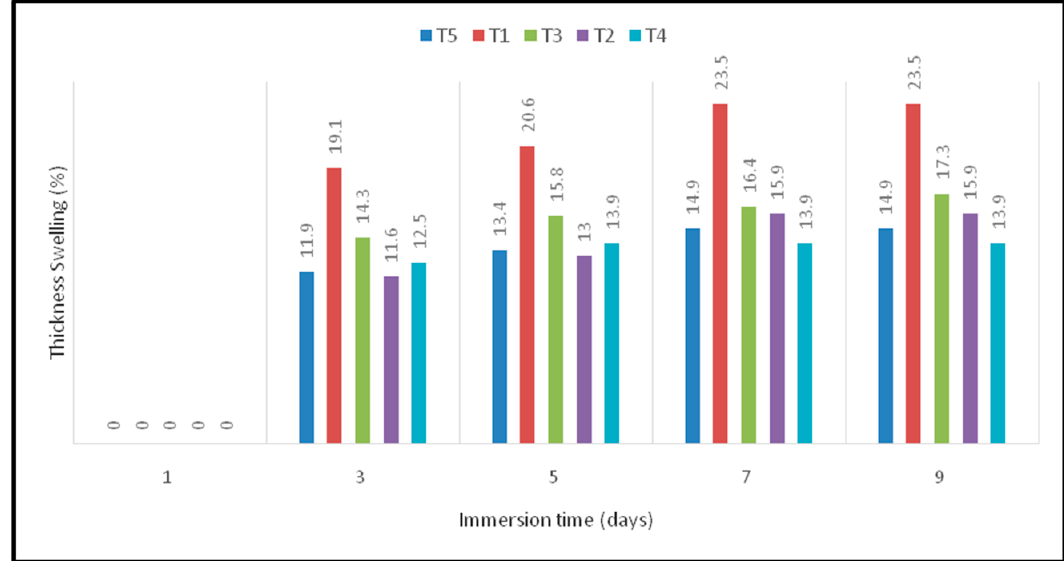
Figure 6. Thickness swelling (%) of oil palm EFB / kenaf woven fiber-reinforced epoxy based bi-layer composites.